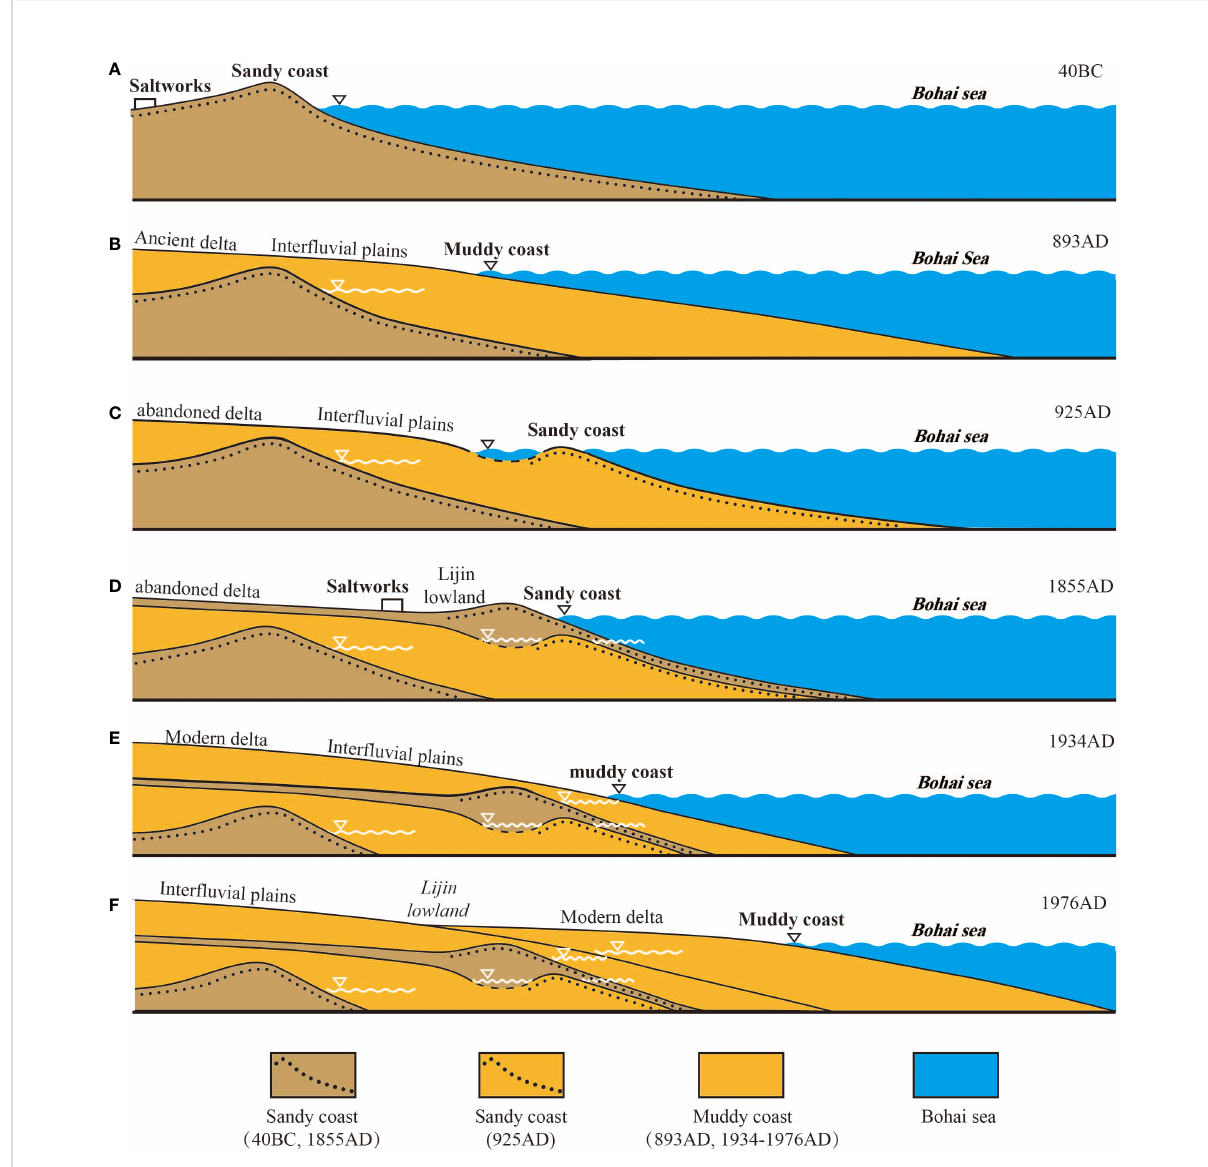
FIGURE 5 Model of the geomorphic evolution of the shallow-buried abandoned Yellow River delta during the last 2000 years. (A) The sandy coast was developed before the ancient Yellow River Delta was formed in 40 BC. (B) The muddy coast was developed before the abandonment of the ancient Yellow River Delta in 893 AD. (C) The muddy coast was transformed into a sandy coast and offshore shell ridges were formed beyond the continental coastline in 925 AD. (D) The sandy coast was developed before the abandoned delta buried by sediments of the Yellow River in 1855 AD. (E) The sandy coast was transformed into muddy coast after 1855 AD. (F) The modern delta deposits prograde and rapidly advance the muddy coast into the